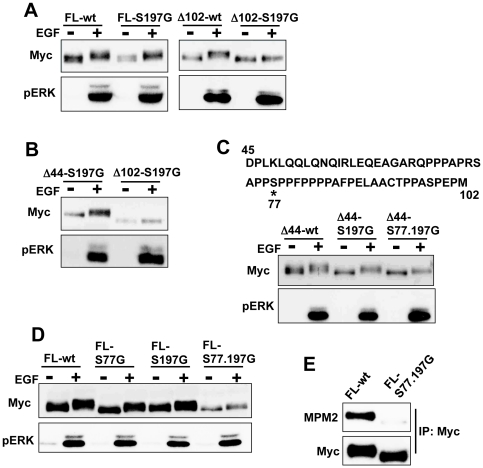
Ser77 is phosphorylated by EGF stimulation.(A) Vero cells were transfected with the indicated mutant palladin. Twenty-four hours later, serum-starved cells were stimulated with EGF for 5 min. Mobility shifts were examined by western blotting. (B) Mobility shifts of Δ44-S197G and Δ102-S197G were examined by western blotting. (C) Amino acid sequence from 45 to 102 is indicated. Mobility shift of the indicated mutant palladin was examined by western blotting. (D) Mobility shift of the indicated mutant palladin was examined by western blotting. (E) Vero cells were transfected with either FL-wt or FL-S77.197G palladin. Twenty-four hours later, cells were stimulated with EGF for 5 min. Cells were lysed and immunoprecipited with anti-Myc antibody and blotted with anti-MPM2 antibody.